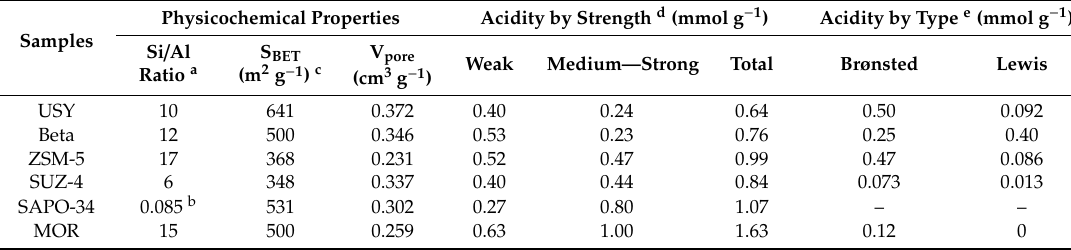
Table 1. Physicochemical and acidic properties of various zeolite samples.